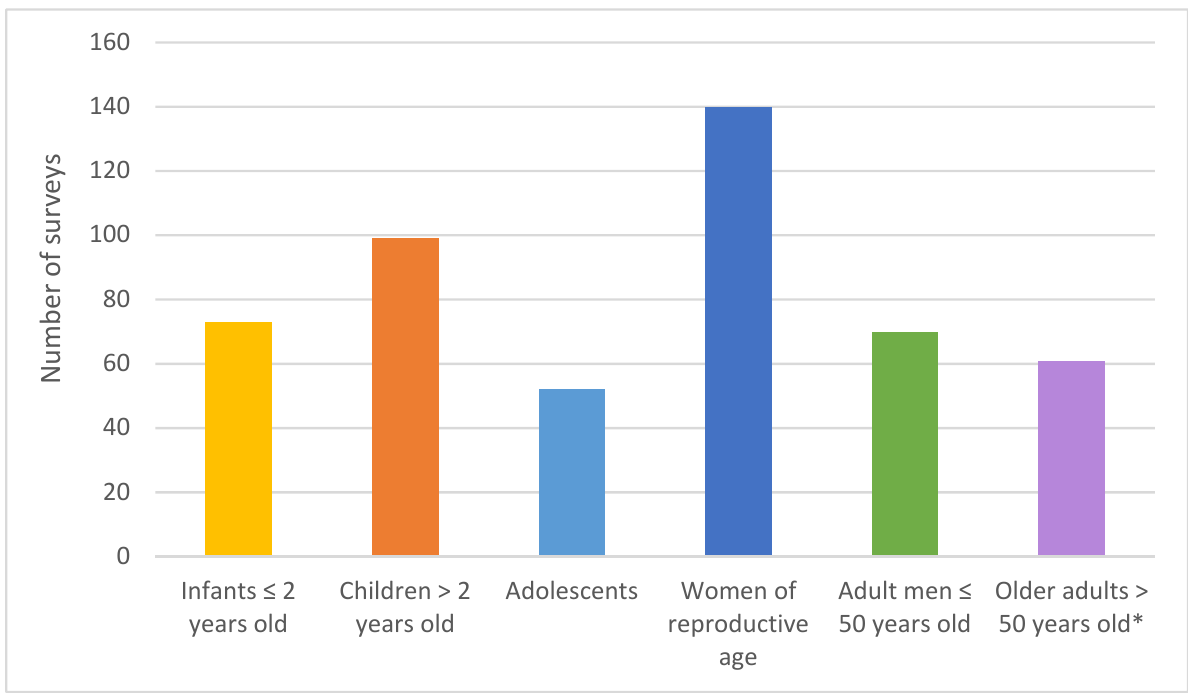
Figure 3. Number of dietary surveys conducted in LMICs from 1980 to 2019 in which different population groups were sampled. * Women older than 50 years were not considered in the older adults’ category if the survey design aimed at specifically sampling women of reproductive age. Data shown reflect the situation as of May 2022.